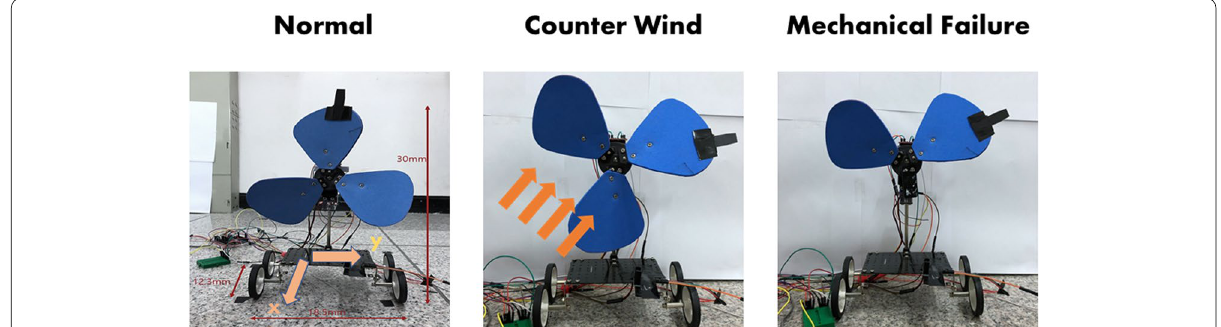
Fig. 8 Photos of the three‑blade fan in the three states: Normal state (left), Counter‑wind state (center), and Mechanical failure state (right). The counter‑wind state indicates the state where the counter‑wind being blown by another fan in front of the fan. The mechanical failure refers to the state in which one of the blades having been removed